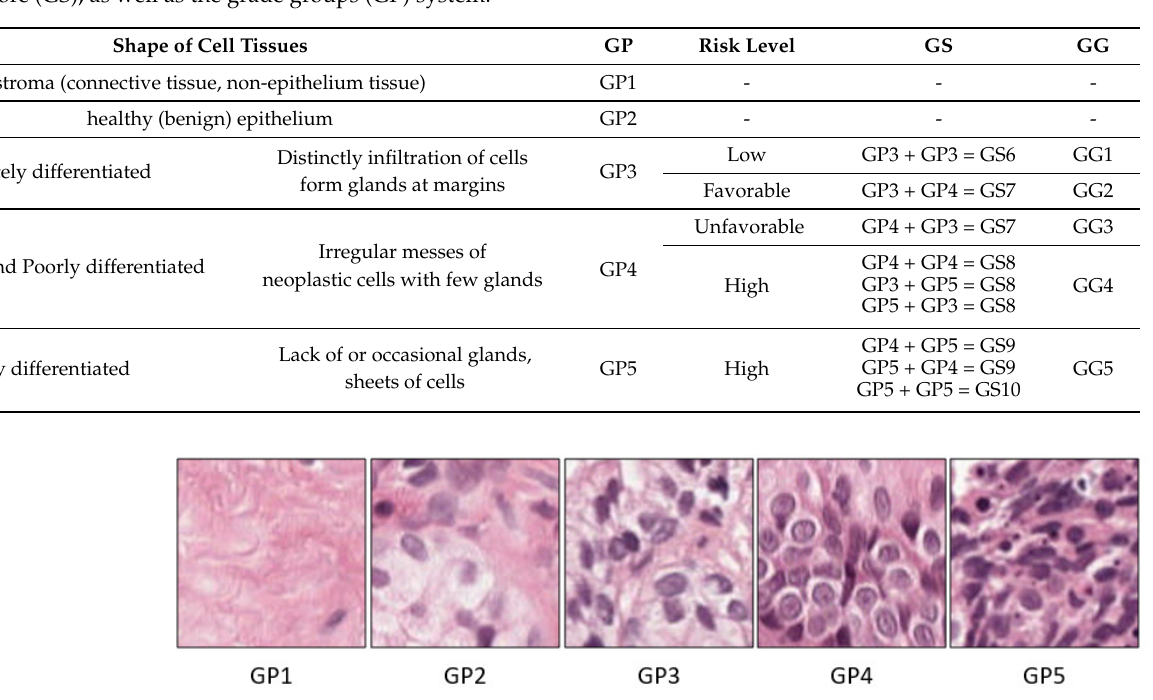
Table 1. Grading systems for a prostate biopsy specimen are the Gleason grading system, the Gleason pattern (GP) and Gleason score (GS), as well as the grade groups (GP) system.